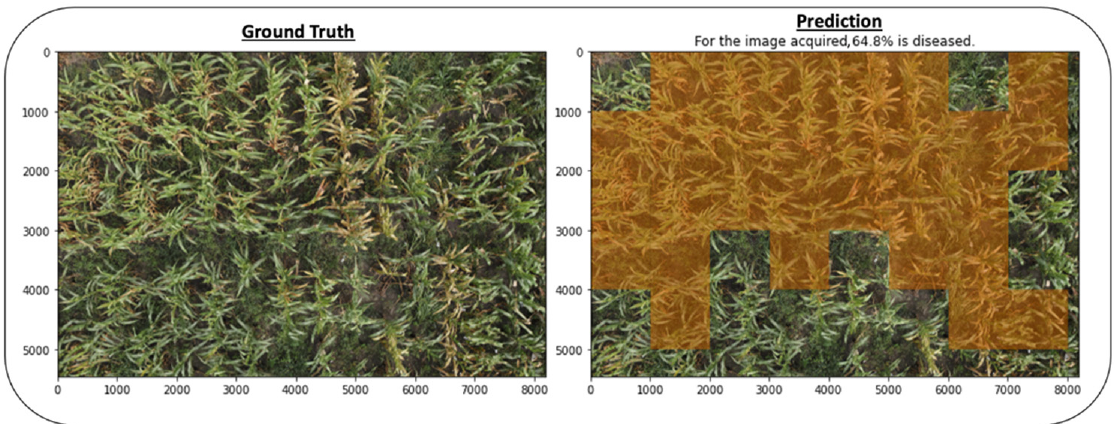
Figure 9. The sliding window algorithm identifies and highlights diseased regions in UAS imagery acquired in diseased fields.